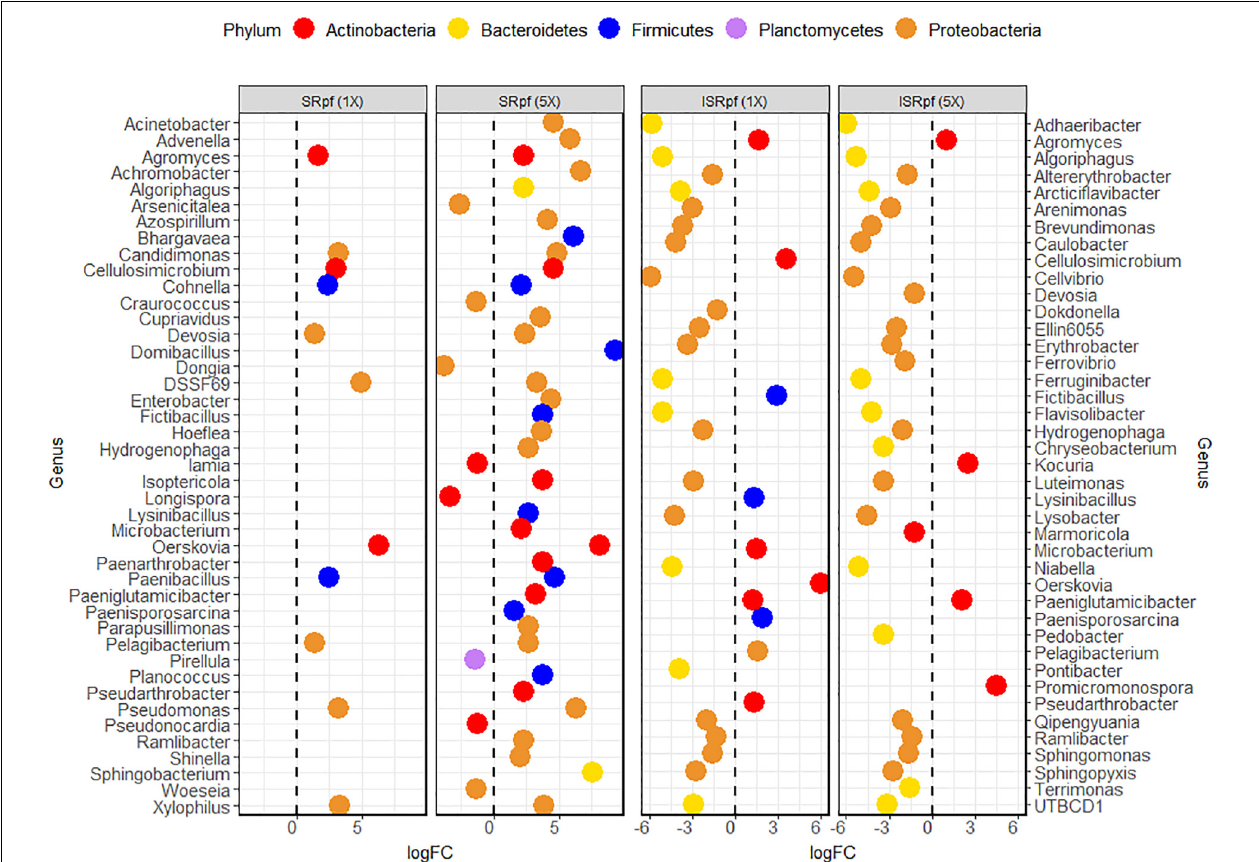
FIGURE 4 | Differential abundance analysis (EdgeR) for the different treatments and their concentration levels. Each treatment and concentration level was compared to the control extraction (extraction with PBS alone).